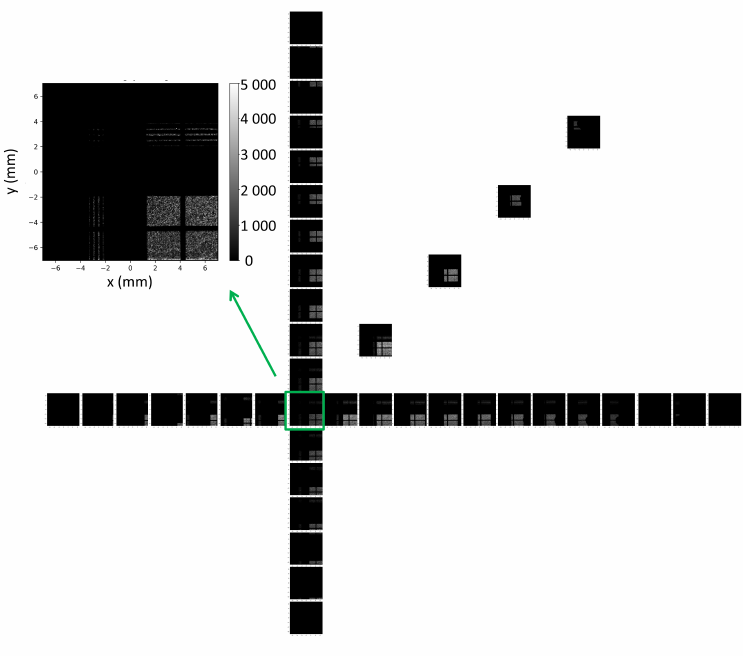
Figure 9. Directional response and FoV tests with an X-ray unit scanned in wide angular range from − 35 to +60 degrees. Results are shown along the X- and Y- directions with step 5 degrees (see the array of black & white detector frames. Measurements along the diagonal direction at selected positions are also included. One frame, at the central position, i.e., at the fully perpendicular direction, is shown in detail (color frame shown at top left)—see also Figure